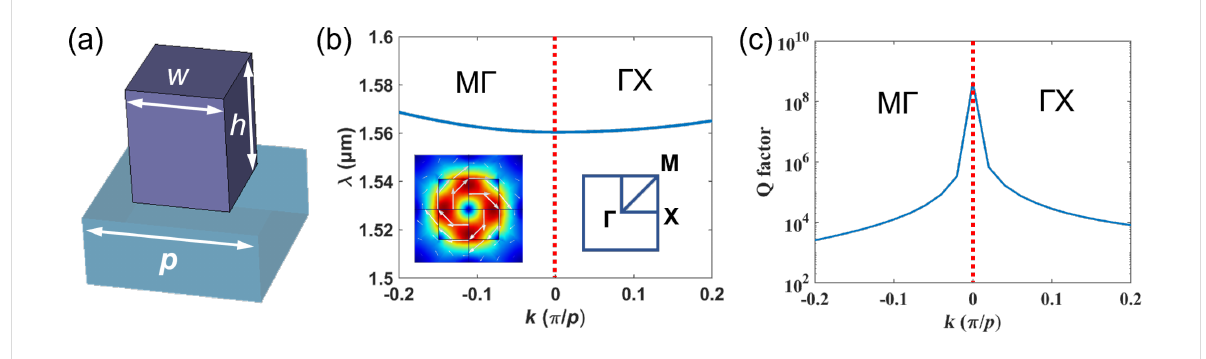
Figure 1: Design of the unit cell. (a) Schematic of a unit cell consisting of an AlGaAs nanoblock on a sapphire substrate. The side length and the height of the nanoblock are w and h , respectively. The period of the unit is p . (b) Band diagram related to the MD BIC mode. The electric field distribu- tion for the mode at the Г point is shown in the inset, where the white arrows indicate the in-plane E field vectors. (c) Q r of the BIC mode as a function of k